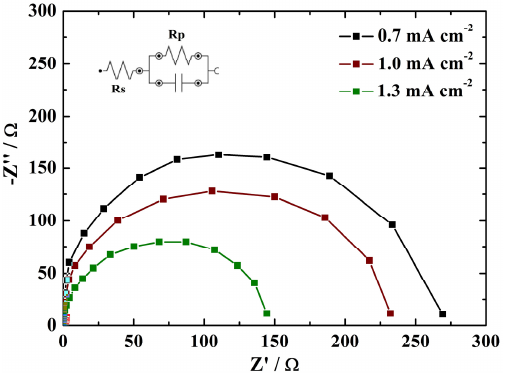
Figure 7. Nyquist plots of the measured (symbols) and fitted (line) impedance spectra of the electrodeposited V 2 O 5 at room temperature for current density of 0.7, 1.0, and 1.3 mA ∙ cm − 2 at a constant electrolyte concentration of 0.5 M. Equivalent circuit is indicated as inset.